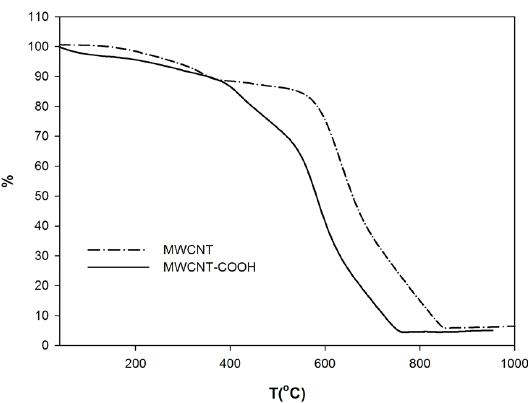
Fig. 6. TGA profile of MWCNT and MWCNT-COOH.